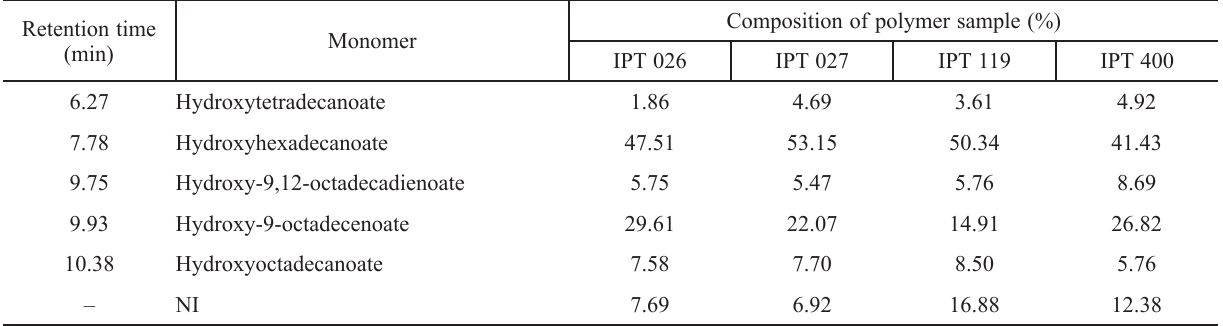
Table 3 – Monomeric profile of the PHAs produced by C. necator and B. cepacia bacteria, using crude palm oil as substrate, obtained by gas chromatography–mass spectrometry in the NIST library Retention time